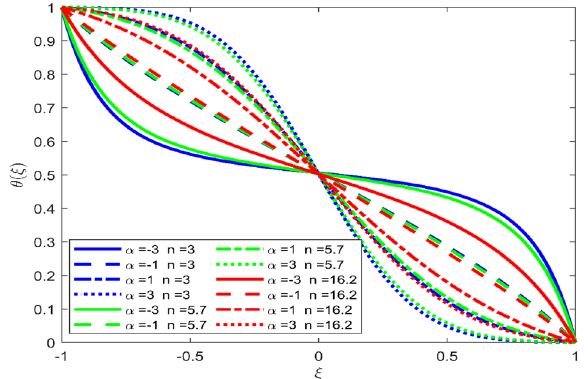
Figure 6. Effect of α upon velocity profile θ(ξ) , for selected values of β = 0.2, m = 1, Ha = 1, φ 1 = φ 2 =